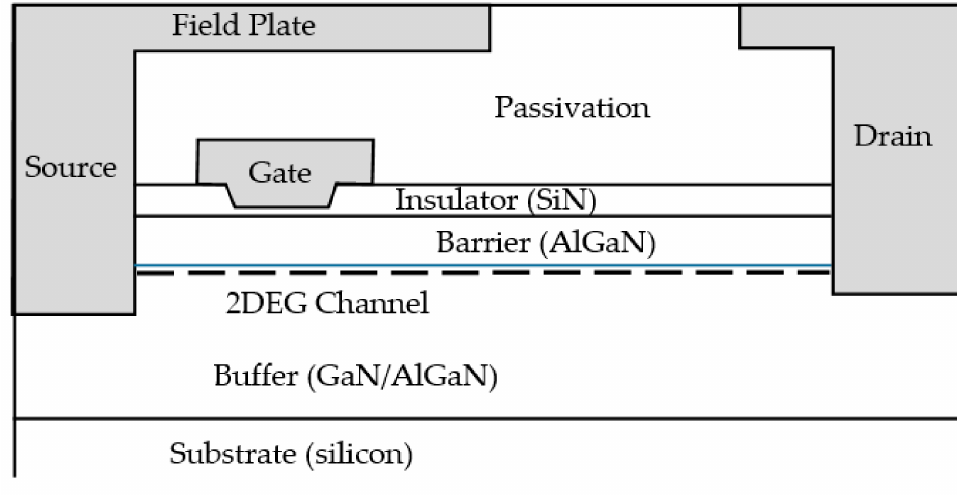
Figure 2. The field plate of the D-mode GaN